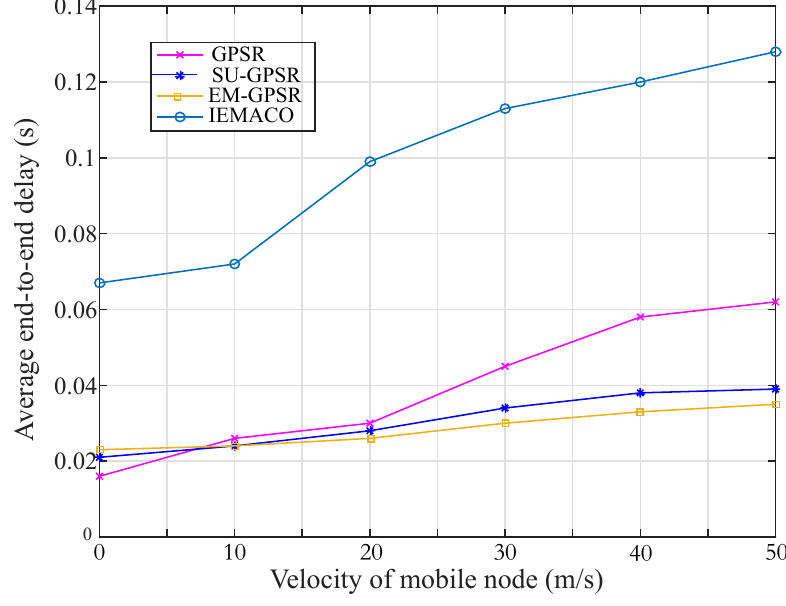
Figure 8. Average end-to-end delay versus the velocity of a mobile node.